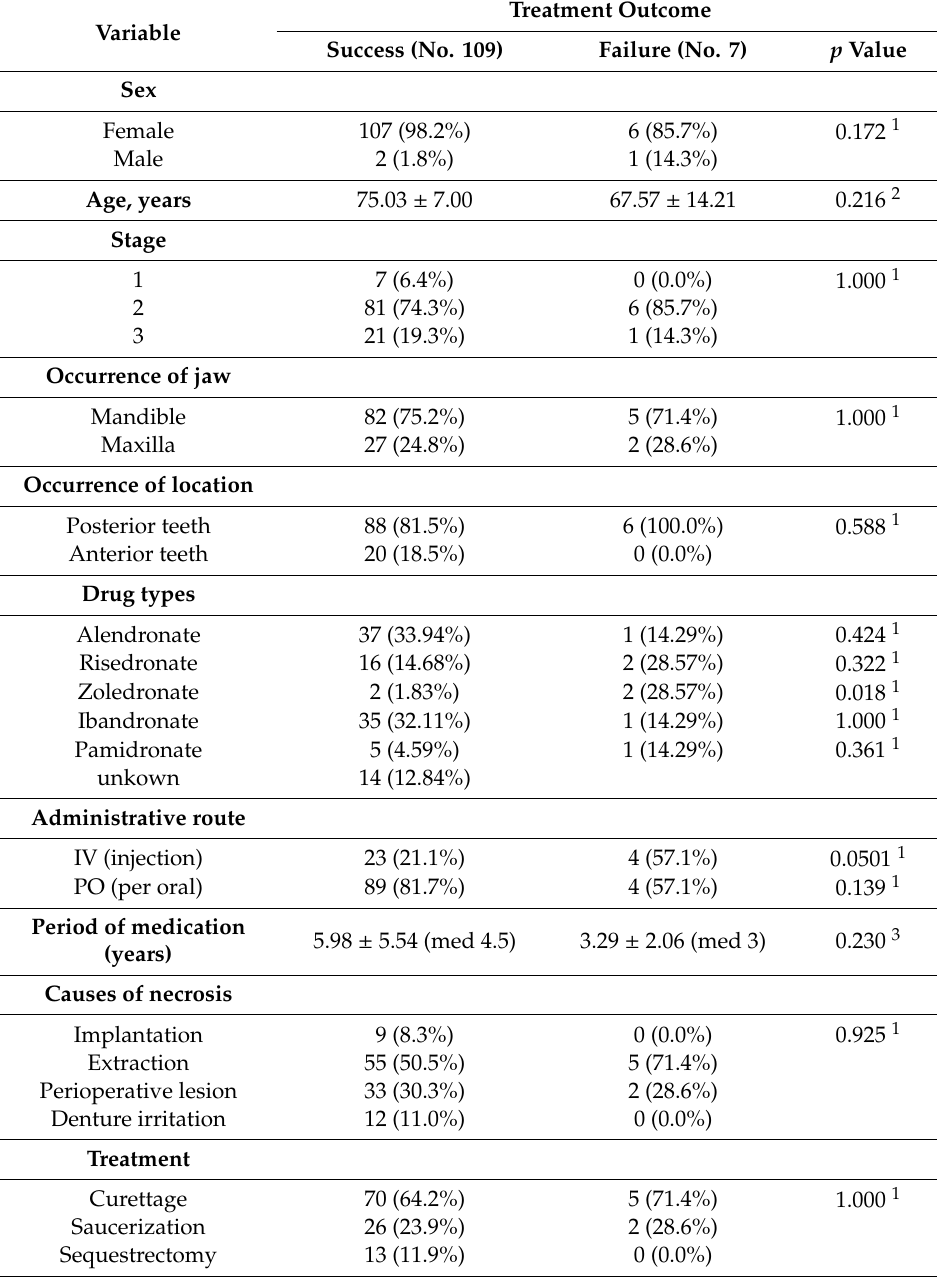
Table 2. Baseline and Clinical Characteristics of Patients in the two